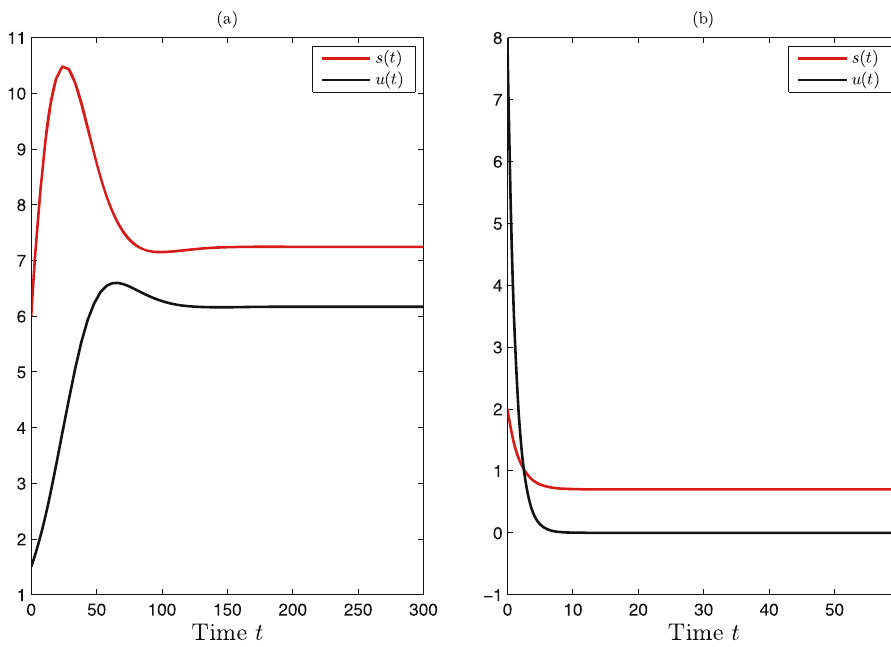
Figure 1: Numerical solutions of system ( 59 ) ( ODE case ) subject to the fi rst and second sets of parameters.